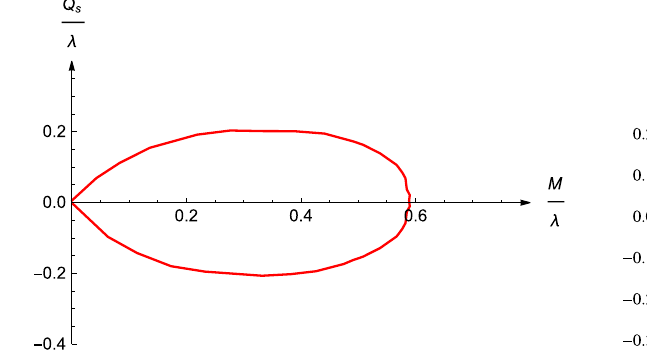
coupling has a finite region of 0 < M /λ < 0 . 587 which is the unstable bound for Schwarzschild black hole, while (Right) quadratic coupling has a band with bandwidth of 0.587 < M /λ < 0.636 which exits within the stable bound for Schwarzschild black hole